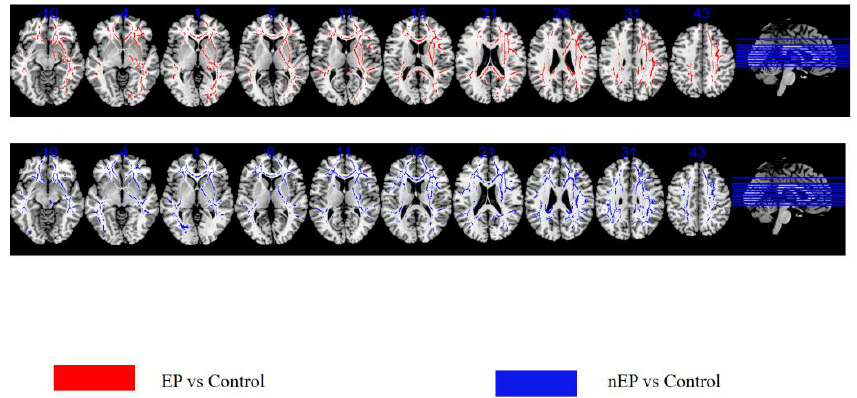
Figure 1. Significant clusters were identified by permutation testing ( n = 5000, and FWE-corrected at TFCE level p <